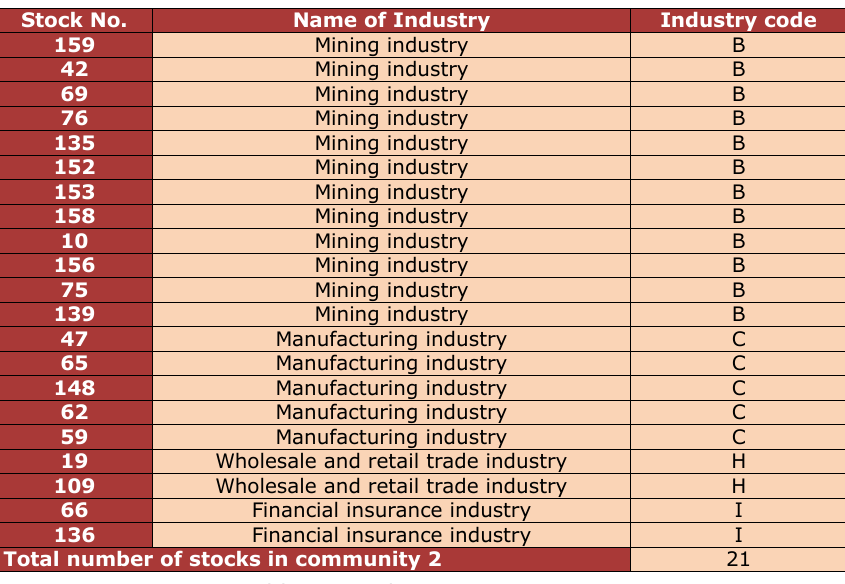
Table 5. Stocks in Community 2